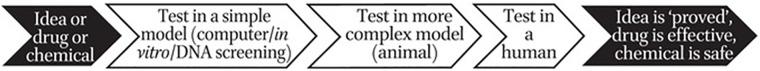
Current paradigm of biomedical research and drug discovery and development.Kindly provided by Taylor [2].